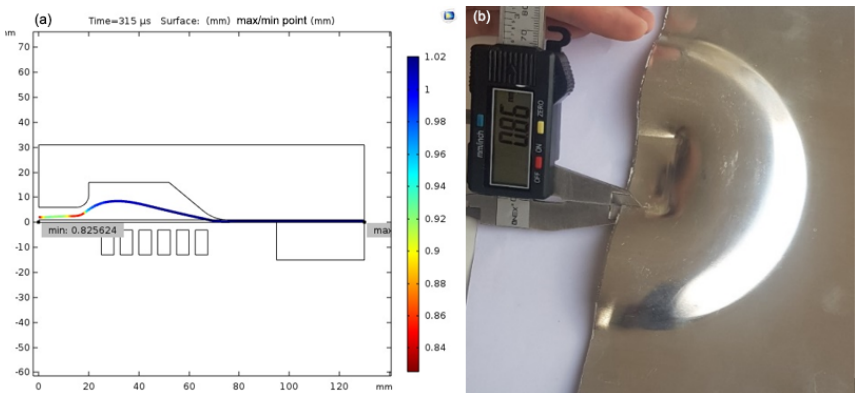
Figure 16. Minimum thickness of deformed sheet condition 1 (voltage = 2400V, thickness = 1.02mm, N = 6). (a) Numerical result and (b) experimental measurement. Table 5. Numerical and experimental sheet deformation. Condition Parameters with ranges Max displacement % Error between Voltage Sheet N